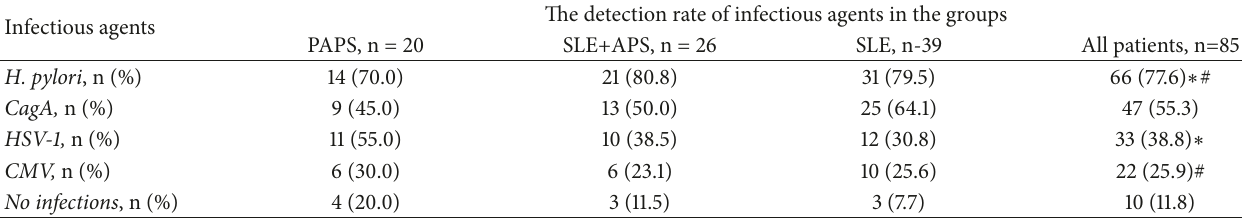
Table 2: The detection rate of H. pylori, HSV-1, CMV in the gastric mucosa of patients with SLE and APS. The detection rate of infectious agents in the Infectious agents